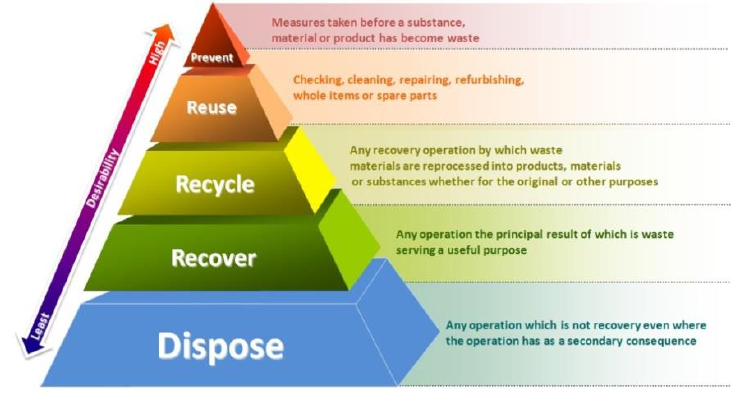
Figure 2. The European unions waste hierarchy (adapted from: Defra [16]).